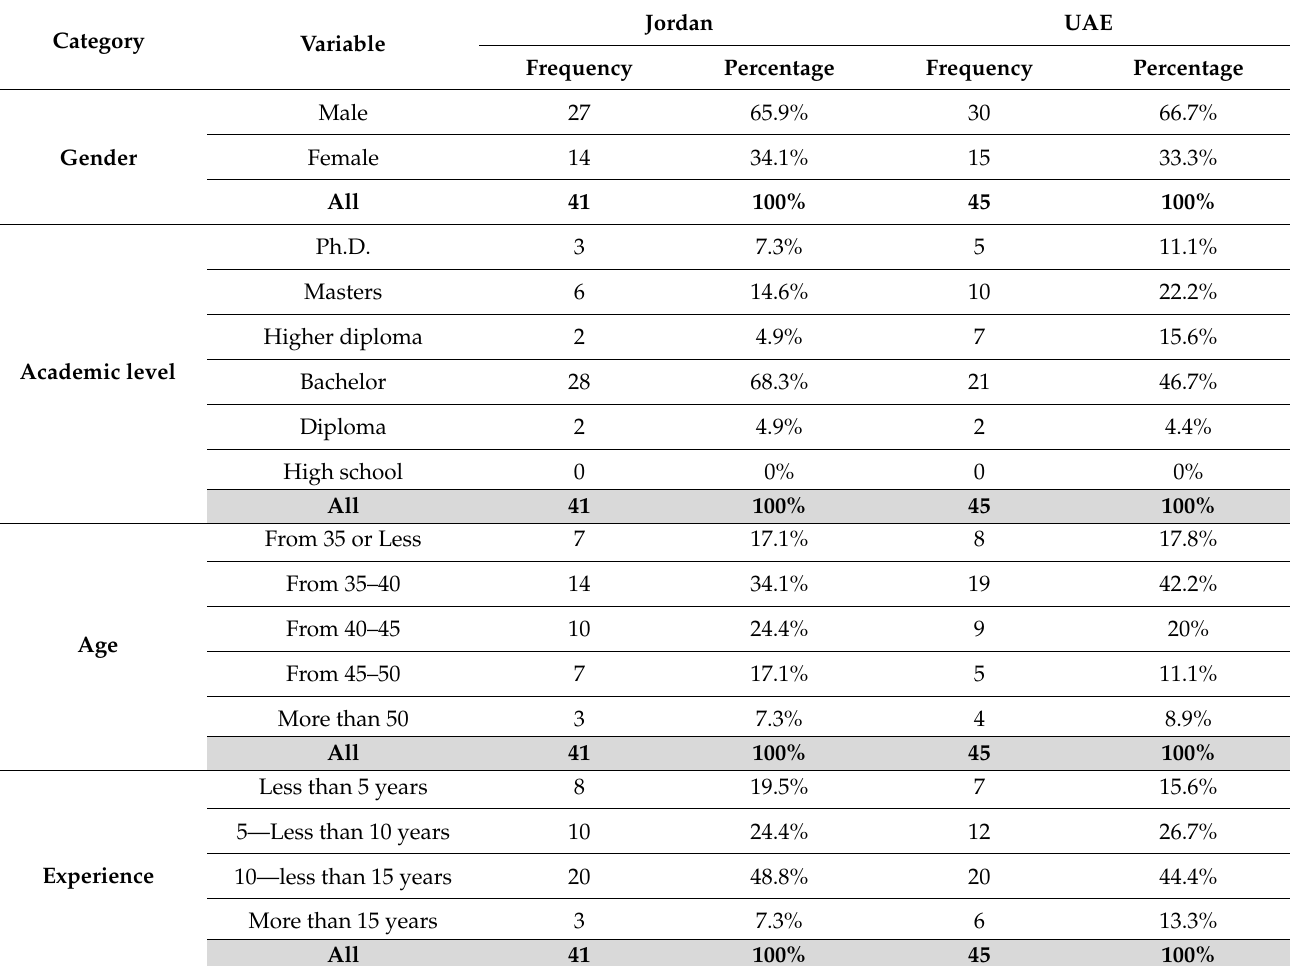
Table 1. The Demographic Distribution of the Study